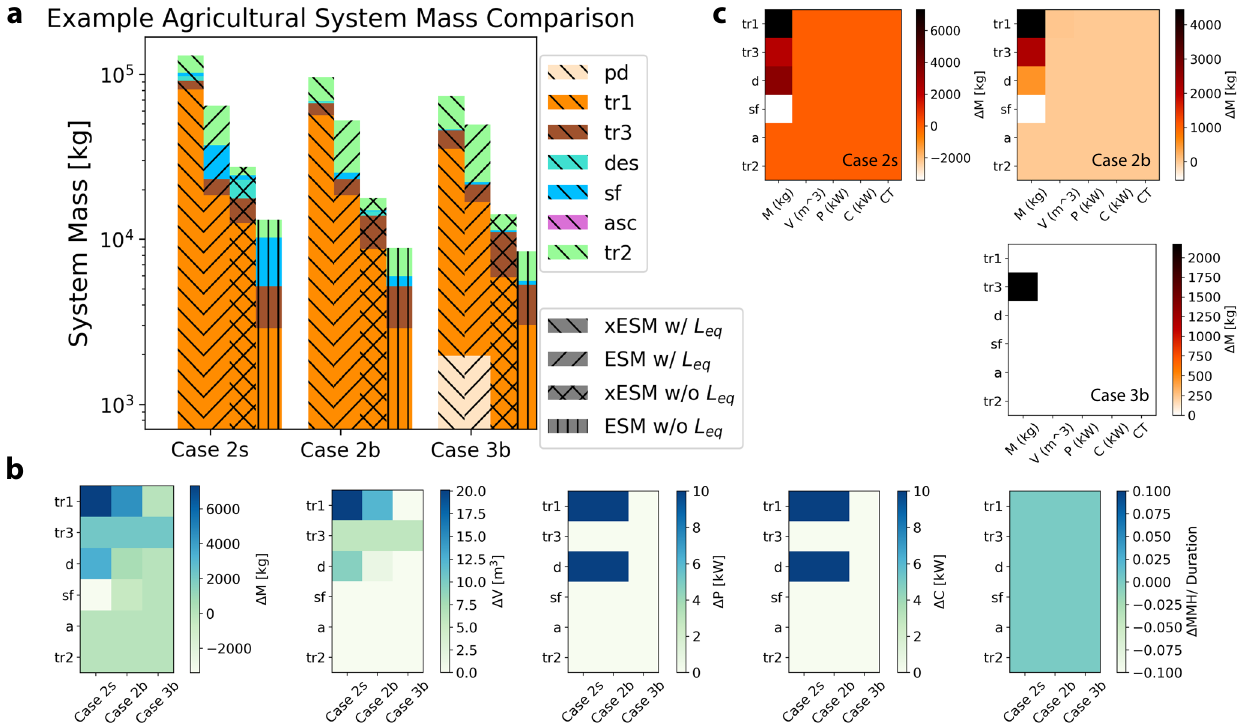
Fig. 4 Comparison of ESM and xESM metrics focused on the stored food cost. a Log-scale comparison of mission segment mass for different food strategies. Case 2s is the food cost of Case 2 in Fig. 3. Case 2b reduces the amount of stored food for sf from 500 days to 70 days, assuming a hypothetical future agriculture system could grow the difference. In Case 3b, the sf inventory is predeployed, and grown food also sustains the majority of sf. The ESM differences between 2s and 2b and between 2s and 3b show the rough mass requirement for the design and development of such an agricultural system. b Raw inventory difference between xESM and ESM mass, volume, power, cooling, and crew time across each mission segment, before the application of location and equivalency factors. c Raw inventory difference between xESM and ESM displayed across the three cases. Legend: Predeployment (pd): tan. Transit 1 (tr 1 ): orange. Transit 2 (tr 2 ): yellow. Transit 3 (tr 3 ): red. Surface operation (sf): blue. Descent (des): grey. Ascent (asc): purple. Extended ESM with Location Factor (xESM w/L eq ): back-slash. Standard ESM with Location Factor (ESM w/L eq ): forward-slash. Extended ESM without Location Factor (xESM w/o L eq ): cross slash. Standard ESM with Location Factor (ESM w/o L eq ): vertical